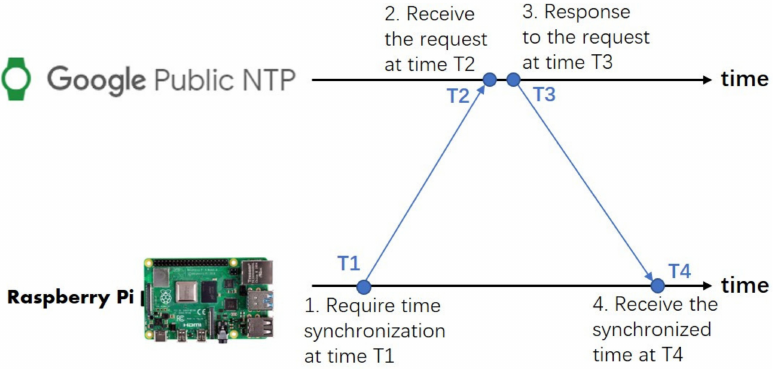
Figure 6. Network Time Protocol (NTP) synchronization procedure.